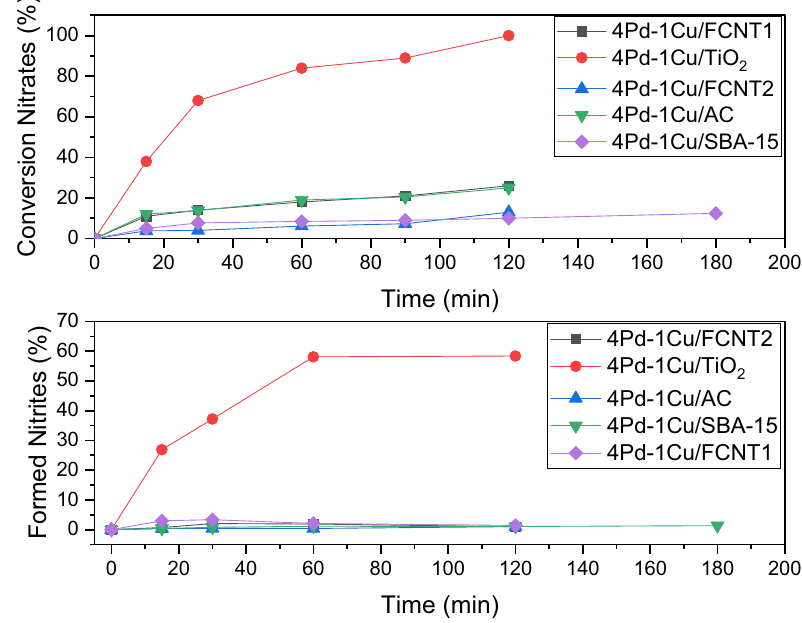
Figure 16: Nitrate conversion ( % ) and formed nitrites percentage ( % ) analyzed by IC after 3 h or 5 h of catalytic reduction using the supported catalysts: 1Pd – 1Cu/FCNT3, 1Pd – 1Cu/TiO 2 , and 1Pd – 1Cu/CNT3 - TiO 2 prepared by method 2 with and without CO 2 fl ow ( C NO ppm, C catalyst = 0.5 g/L ) .